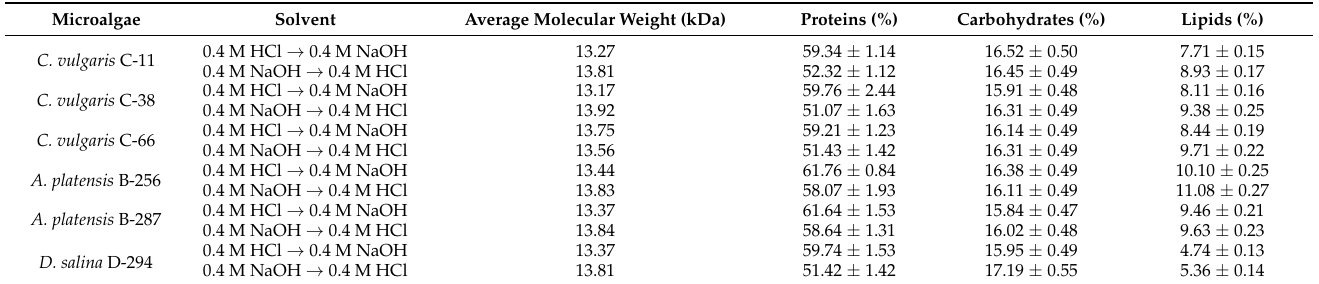
Table 4. Characterization of proteins, carbohydrates, and lipids obtained during joint extraction with acid and alkali.